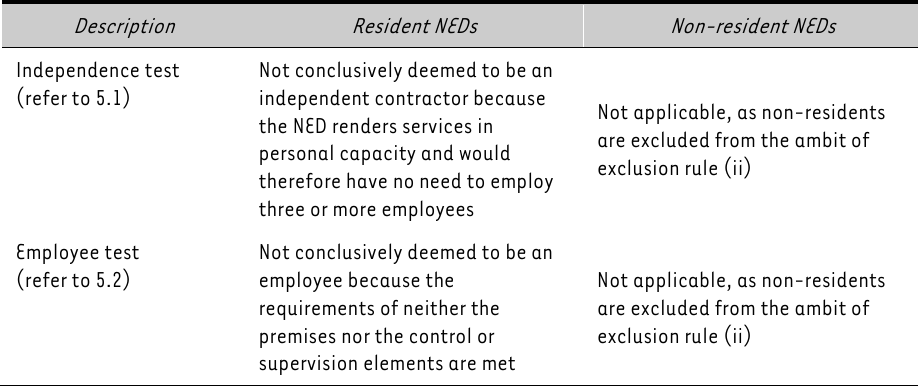
Effect of the statutory tests on the classification of NEDs